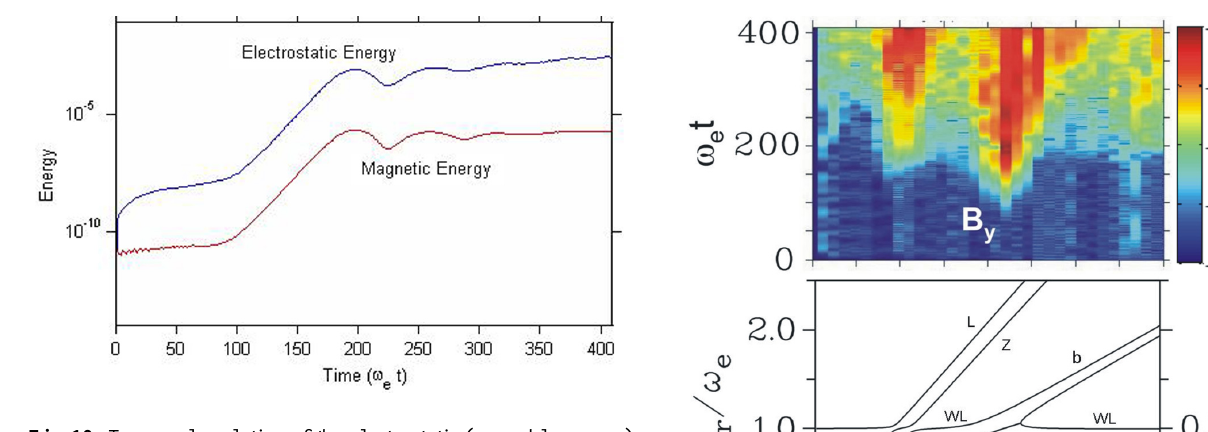
Fig. 10. Temporal evolution of the electrostatic (upper blue curve) and magnetic energy (red curve). The parameters used in the simu- lation are: G = 5, θ = 5 ◦ , n b / n o = 0 . 002, V b /c = 0 . 5. Saturation of both components occurs at about ω e t = 180.